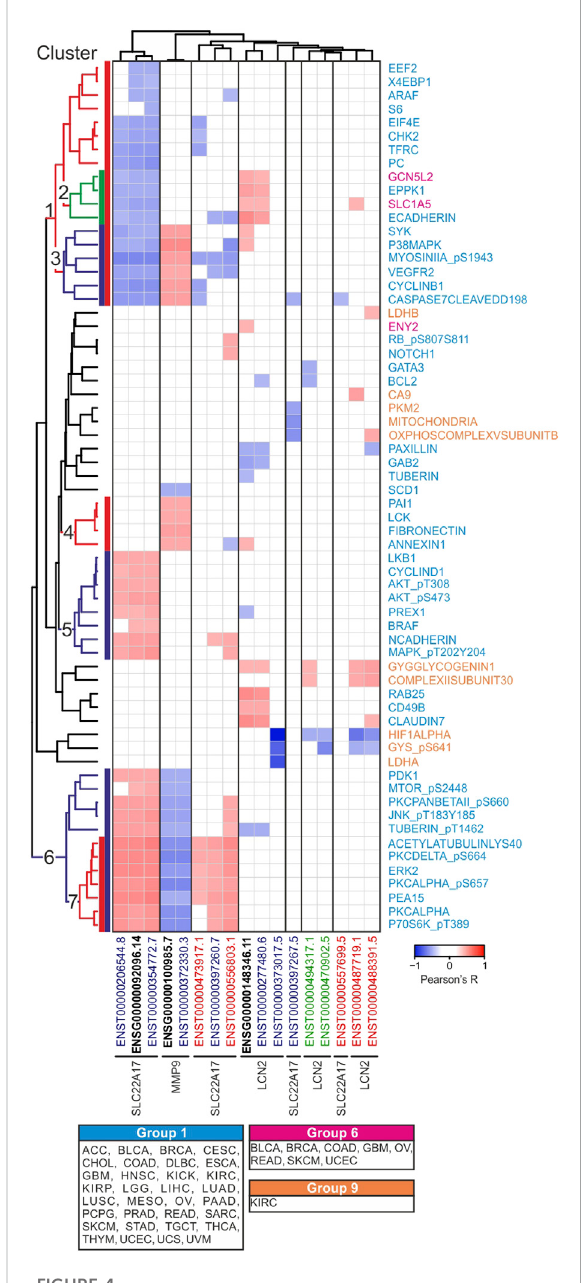
FIGURE 4 Correlation analysis between LCN2 , SLC22A17 , and MMP9 gene/isoforms expression and protein levels in PANCAN tumor samples. Correlation with Pearson ’ s r ≥ 0.3 or ≤ − 0.3 and p ≤ 0.05 are included in the heatmap. The average linkage clustering method and Euclidean distance measurement method were applied for grouping similar data in seven representative clusters. Each protein is labeled with three different colors corresponding to 1, 6, and 9 tumor groups (Supplementary Table S6). Black bold labels indicate the LCN2 , SLC22A17 , and MMP9 genes (ENSG). Coding ENST isoforms: blue; non-coding ENST isoforms: green; retained intron ENST isoforms: